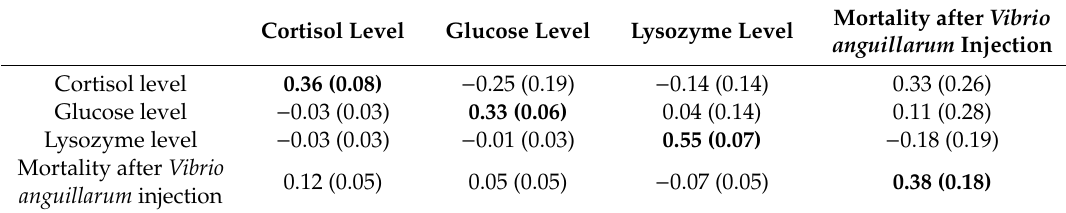
Table 3. Estimates of heritability (bold), genetic correlation, and phenotypic correlation (above and below the diagonal, respectively). Standard errors are in